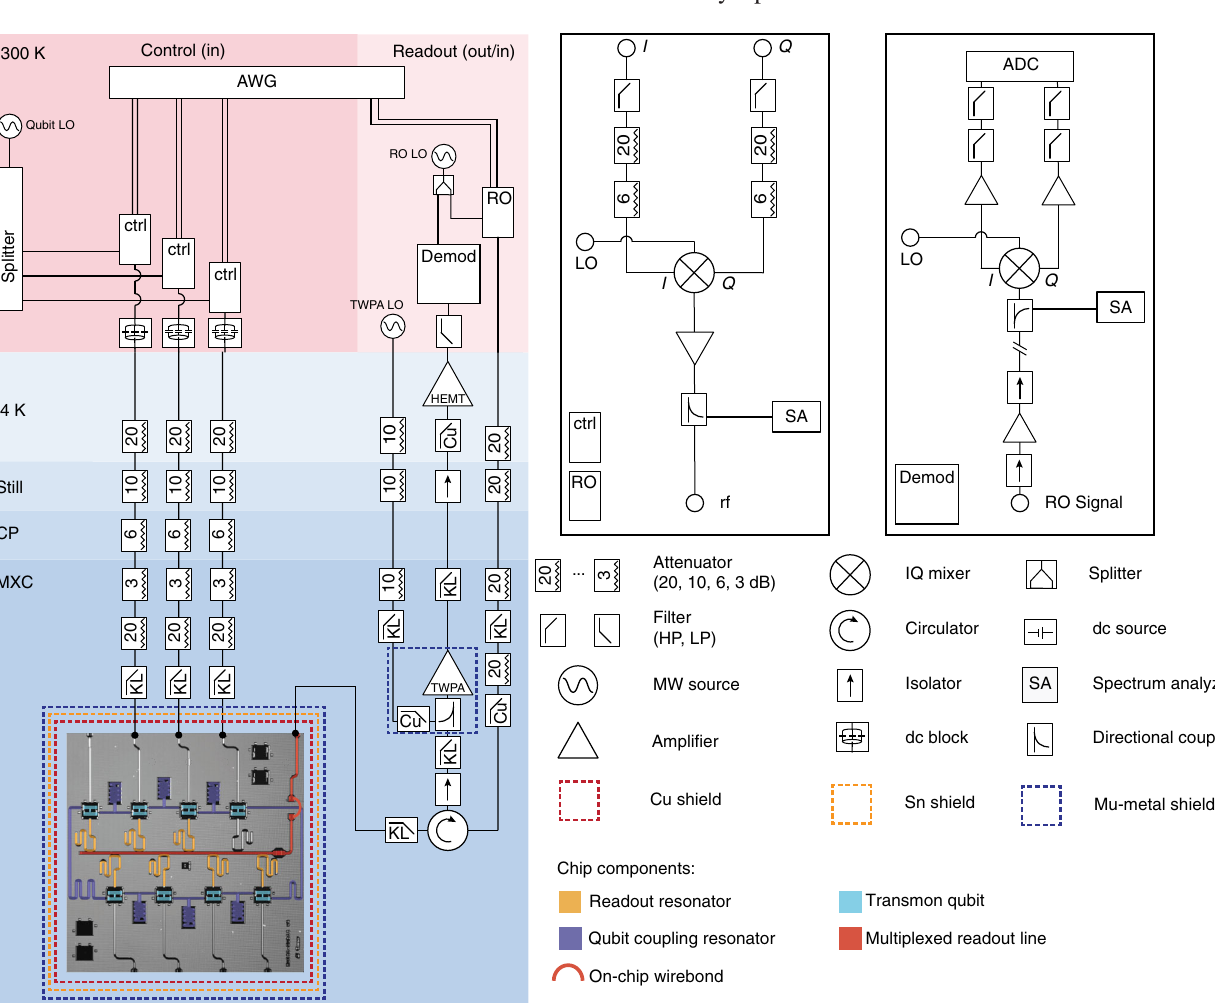
FIG. 6. Microwave electronics inside and outside the dilution refrigerator. CP, cold plate (100 mK); MXC, mixing chamber (10 mK). Any additional description of terms can be found in Appendix A. Abbreviations: ADC, analog to digital converter; MW, microwave; KL, name of a commercial microwave filter